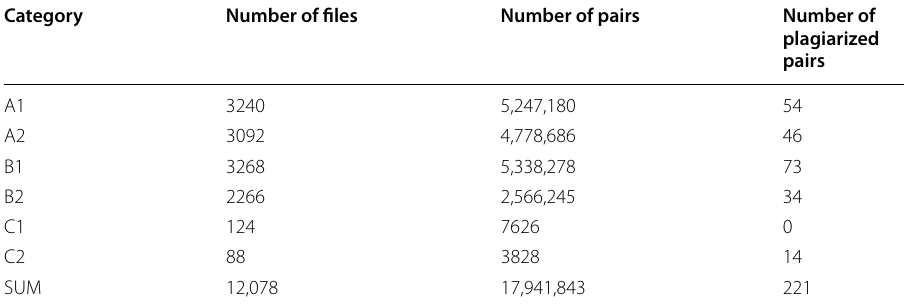
Table 5 The number of files and pairs of SOCO-TEST after removing corrupted files Category Number of files Number of pairs Number of